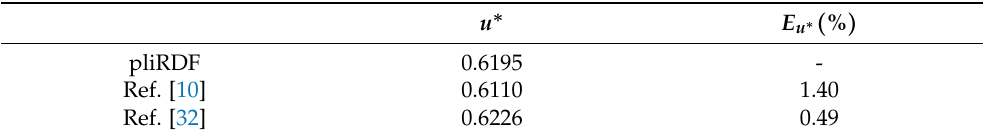
Figure 10. Evolution of Ga ( a ) and Φ ( b ) for the 3D C2 case provided by plicRDF compared with Ref. [10]. Table 12. Benchmark results for the 3D C3 case (M3 mesh) compared against numerical data from Ref. [10] and experimental data Ref. [32]. Absolute error E has as reference value the plicRDF values. u ∗ = u y / U g